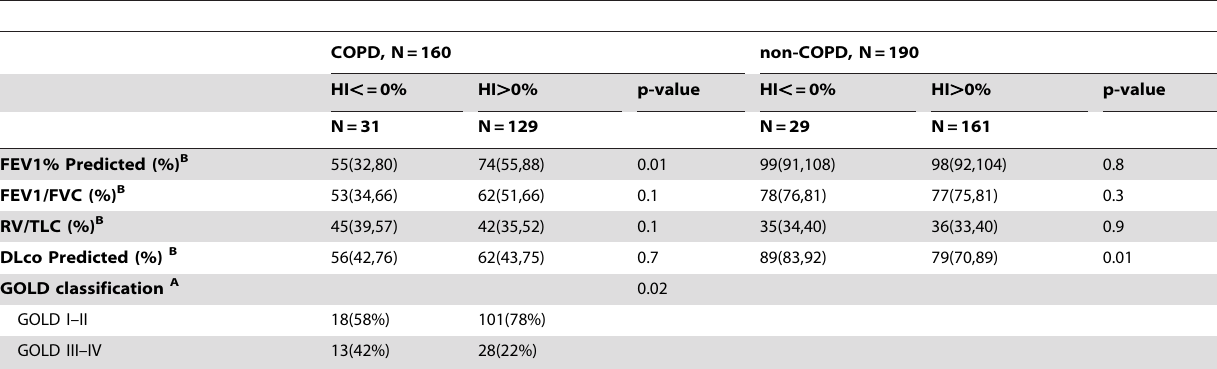
Table 2. Pulmonary function measures and COPD classification of subjects classified as having lower and upper lung dominant emphysema, stratified by emphysema heterogeneity and disease severity.